Question: In one sentence, what is this figure communicating?
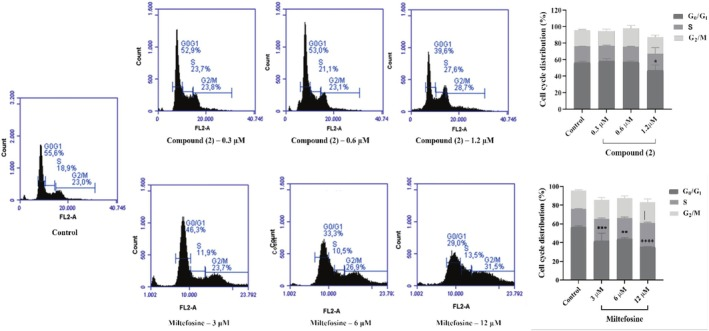
Answer: Flow cytometry histograms of L. infantum promastigote cells treated with 2 and miltefosine. Parasites were incubated with the compounds for 24 h. Cells of untreated promastigotes were used as a negative control. Percentages correspond to the quantification of cells at each phase of the cell cycle. Cell counts in treated wells were compared to those in untreated wells using Dunnet test, and statistical significance was set at * p < 0.01, ** p < 0.003, *** p < 0.001, and **** p < 0.0001. Data shown is representative of three independent experiments.